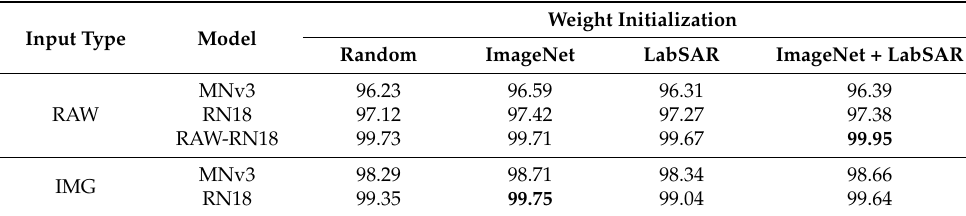
Table 3. Comparison of performance of all considered raw and image-based classification models in combination with all different weight initialization procedures on the validation set. The metric used is mean average precision